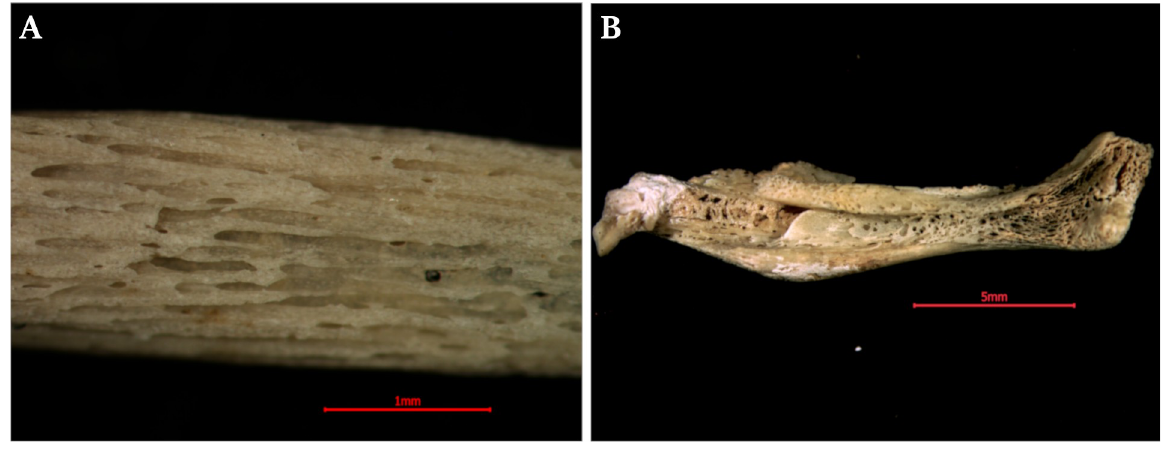
PLOS ONE | https://doi.org/10.1371/journal.pone.0254173 July 2,